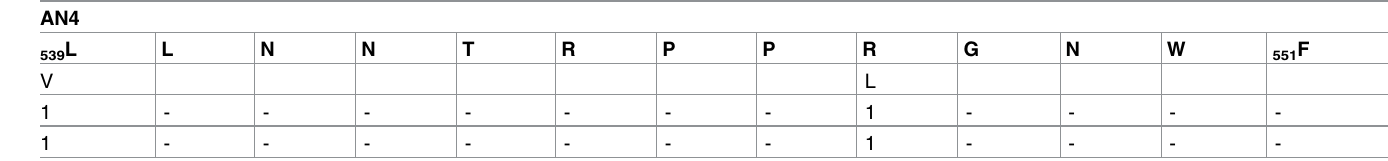
Table 8. Tolerance to the amino acid substitution in the epitopes targeted by VF-Fab1b-5-1.